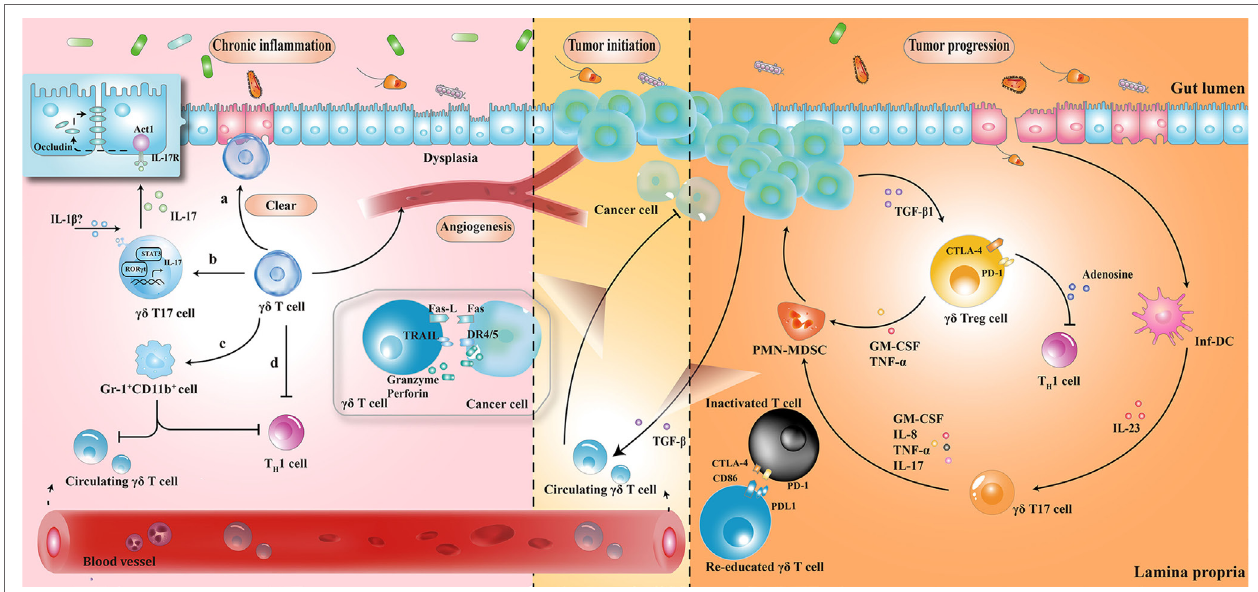
FigURe 2 | The roles played by γδ T cells at different stages of colorectal cancer development. (1) During chronic inflammation, γδ T cells can limit excessive inflammatory response and maintain homeostasis by (a) removal of impaired epithelial cells; (b) secretion of protective IL­17; (c) enhancement of Gr­1 + CD11b + suppressor cell infiltration; and (d) regulation of αβ T cell functions. (2) At the initiation of tumor formation, circulating γδ T cells can recognize and kill cancer cells, but they are reprogrammed with cancer development. (3) At stages of tumor progression, IL­17 and granulocyte macrophage colony­stimulating factor (GM­CSF), produced by γδ T cells in response to IL­23 and transforming growth factor beta 1 (TGF­ β 1) from inflammatory dendritic cells (inf­DCs) and cancer cells, are essential for the recruitment of polymorphonuclear myeloid­derived suppressor cells (PMN­MDSCs), consequently inducing a cascade of suppressive immune responses. CTLA4, cytotoxic T lymphocyte­associated protein­4; PD­1, programmed cell death protein 1; TNF­ α , tumor necrosis factor α ; IL­17,